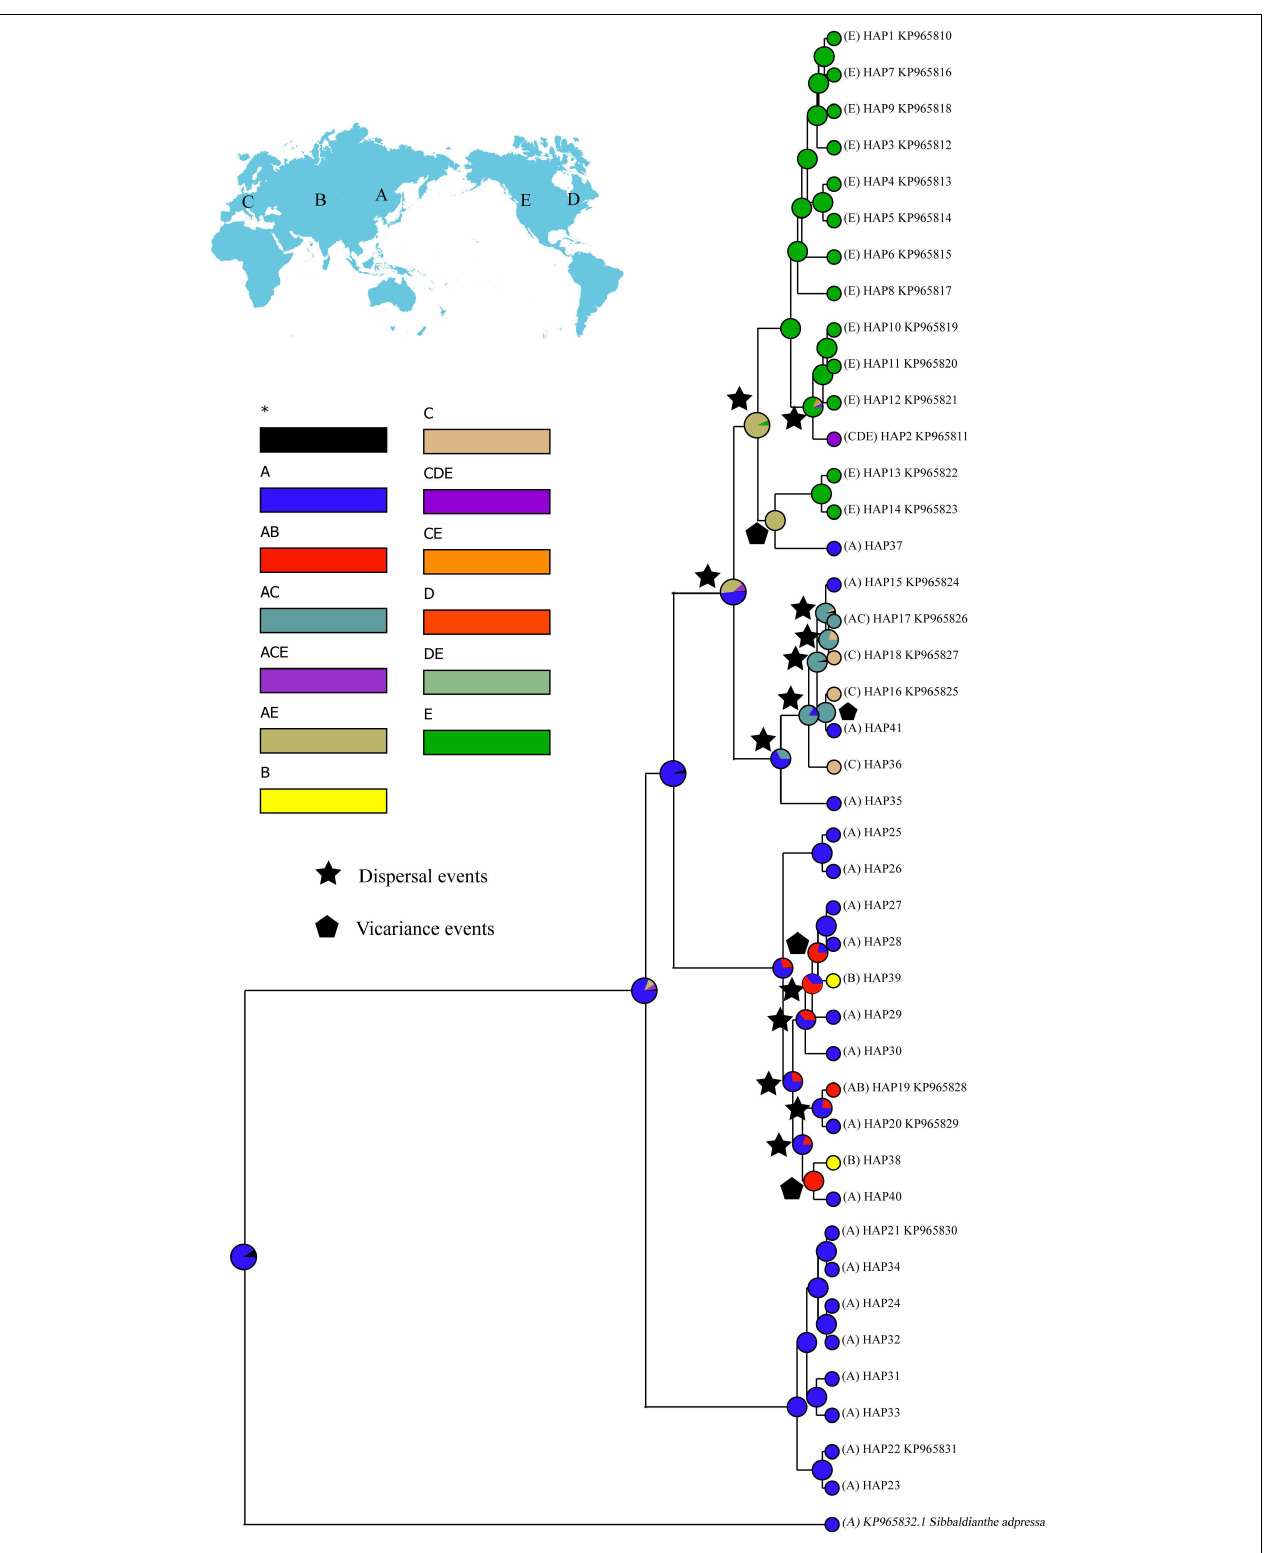
FIGURE 4 | Ancestral distributions reconstructed by RASP. A, Eastern Asia; B, Central Asia; C, Western Eurasia; D, eastern North America; E, western North America.